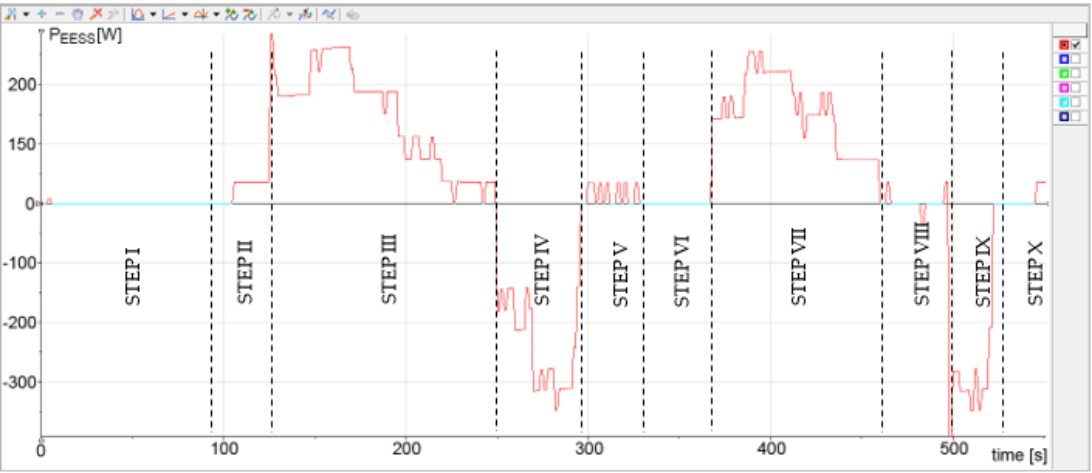
Figure 11. Power exchanged from the electrochemical energy storage system (EESS) with the SUN.